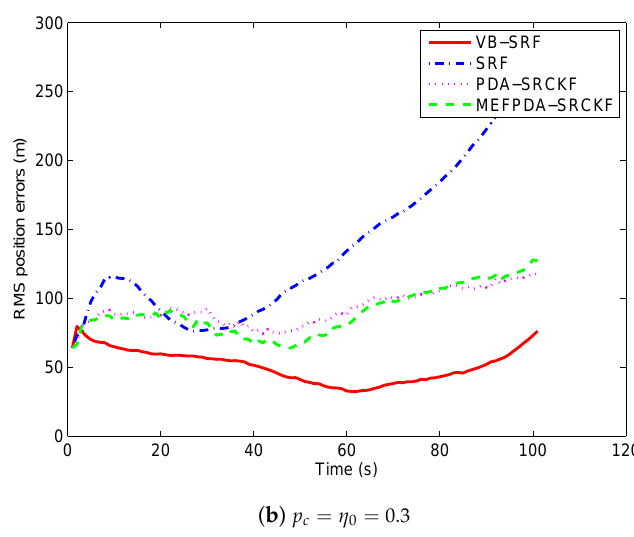
Figure 8. RMS target position errors with mistuned clutter probability in Scenario